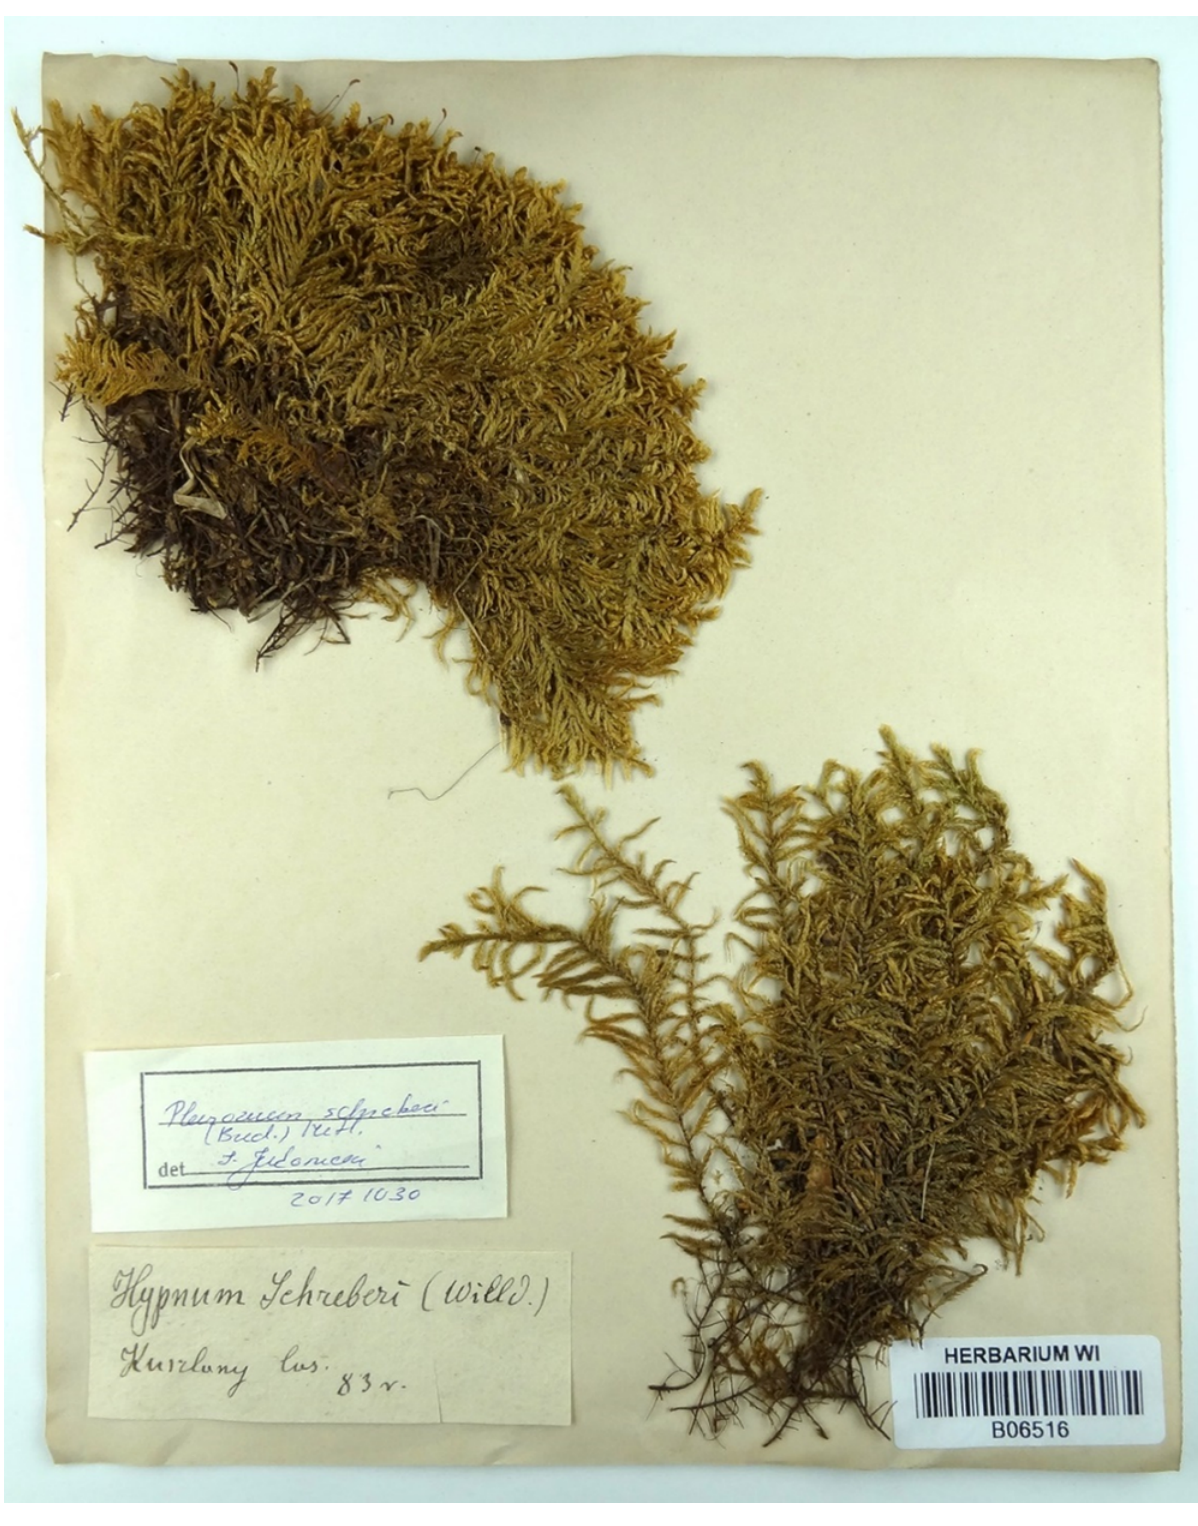
Figure 5 Specimen collected in Kuszlany, the place where K. Szafnagel lived and died (now in Belarus).